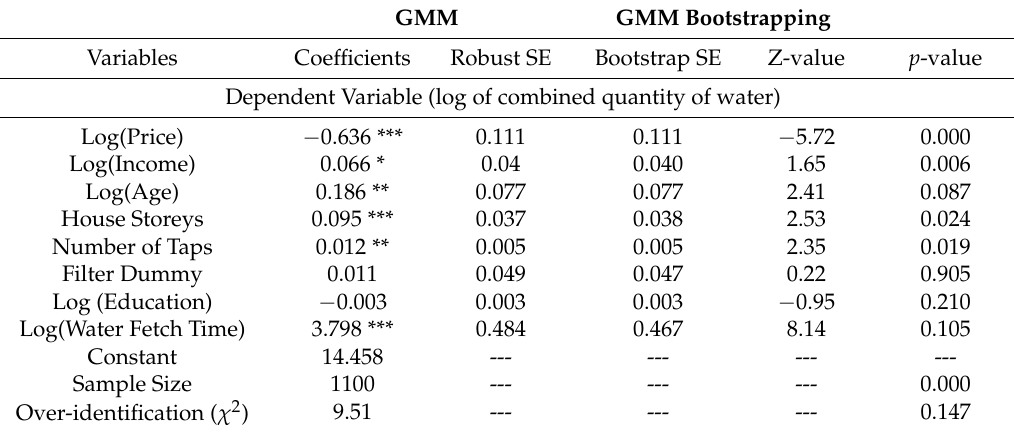
Table A3. Generalized method of moment estimation of residential water demand (combined).